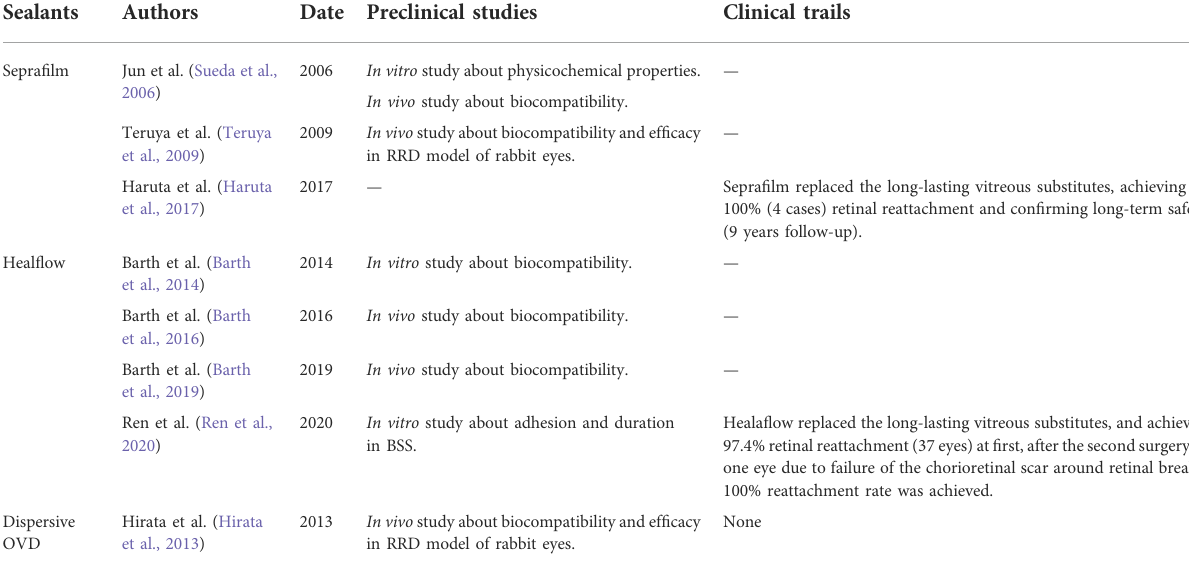
TABLE 3 The summaries of studies about sealants based on polysaccharides as retinal patches for the treatment of RRD. Sealants Authors Date Preclinical